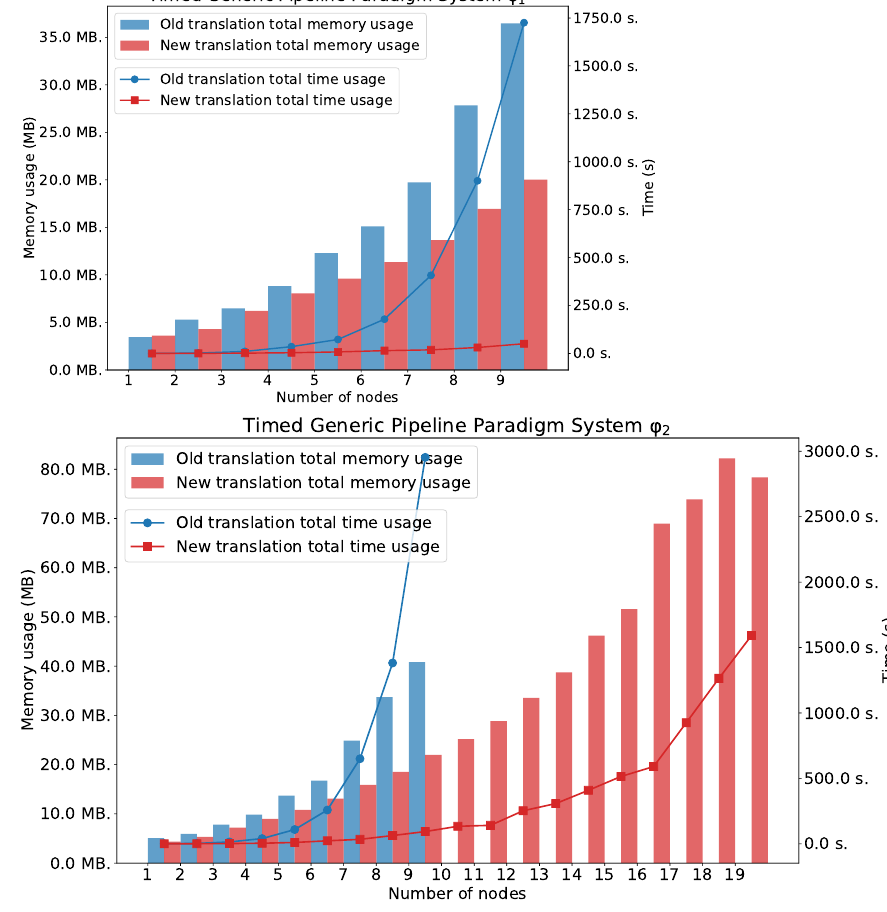
Figure 9. ϕ 1 and ϕ 2 : TGPP with n nodes. Charts in Figure 10 shows the total time usage and total memory usage for TGPP needed for verification ϕ 3 . The second plot shows the number of generated clauses and